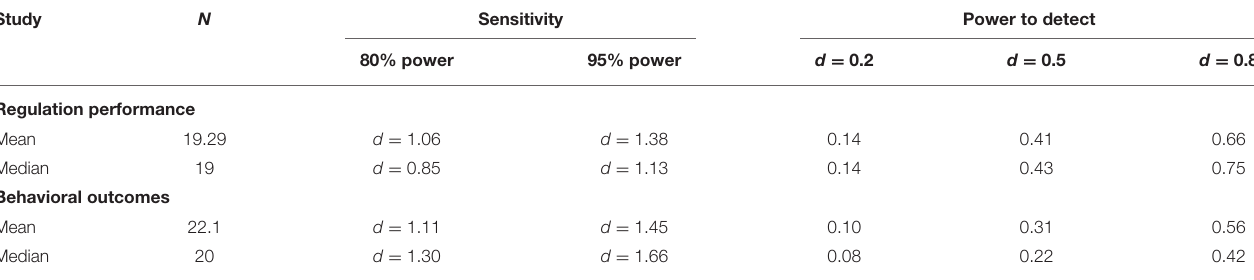
TABLE 5 | Sensitivity and statistical power for reported